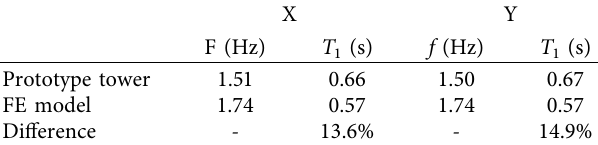
Figure 3: Measured real (a) angle steel and (b) example of the installed three-directional acceleration transducers used for the measurements. Table 5: Comparison of the natural periods between the model and the prototype